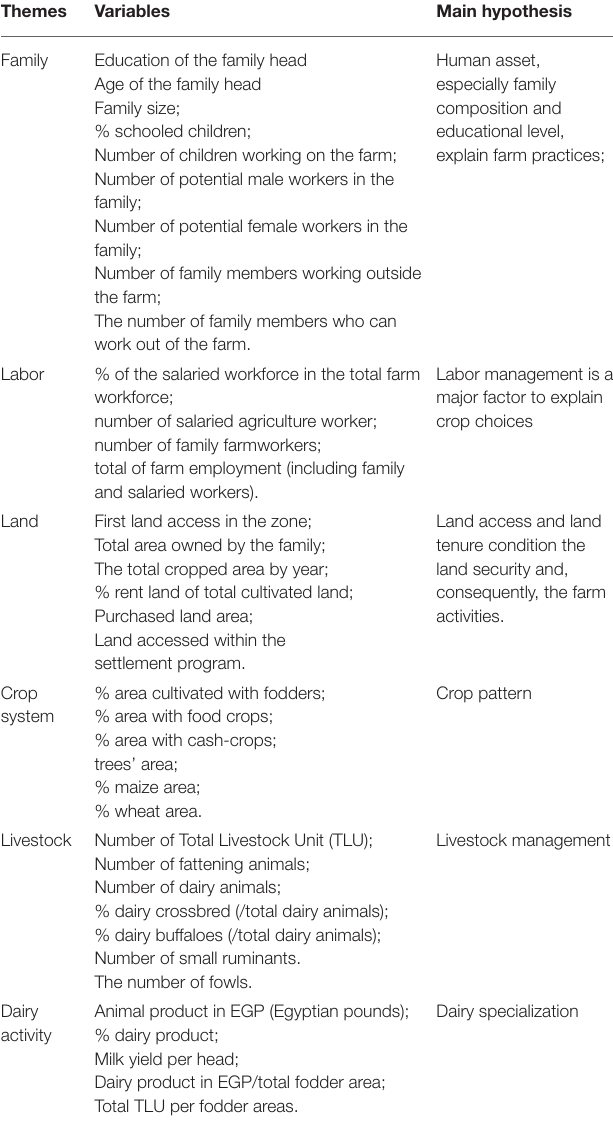
TABLE 1 | Active variables classified into six thematic groups to represent the diversity of family farming systems in the newly reclaimed lands